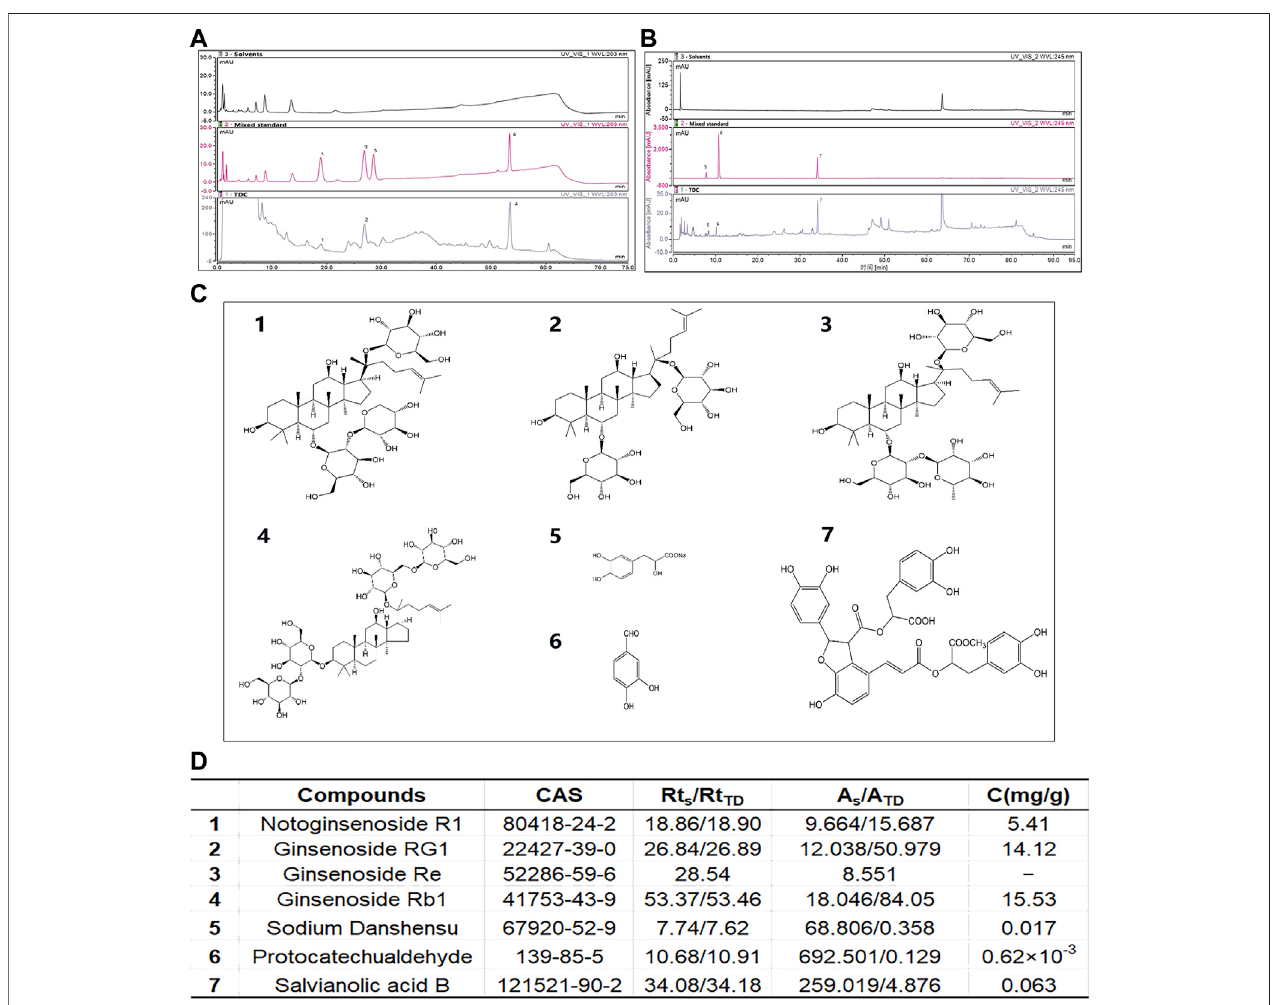
FIGURE 1 | Identi fi cation of major chemical components in TDC (A) At 203 nm, solvents (top panel) , mixed standard (middle panel) , and water-soluble componentsofTDC (bottompanel) weredeterminedbyHPLC.TheAcetonitrile-deionizedaqueoussolutionwasselectedasthemobilephase (B) At245 nm,solvents (top panel) , mixed standard (middle panel) , and water-soluble components of TDC (bottom panel) were determined by HPLC. Methanol-0.1% phosphoric acid aqueous solution was selected as the mobile phase (C) Chemical structures of the seven identi fi ed components in TDC (D) The name of the compound in TDC, retentiontime(Rt S andRt TD representtheretentiontimeofthestandardcomponentandTDCcomponentrespectively),peakarea(A S andA TD representthepeakareaof the standard component and TDC component respectively), and the content of each component in TDC. C (mg/g): Concentration in mg per g of total input. It is noted that because of the trace amount of compound 3 Ginsenoside Re, its quantitation was not successful.